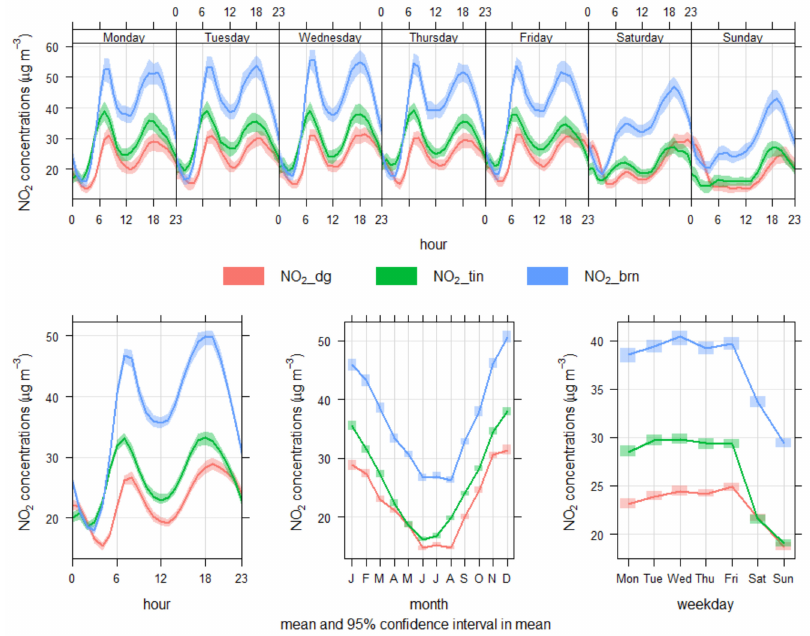
Figure 9. Time variation plots of NO 2 concentrations ( µ g/m 3 ) in Sheffield at the three AURN AQMS: Barnsley, Tinsley and Devonshire